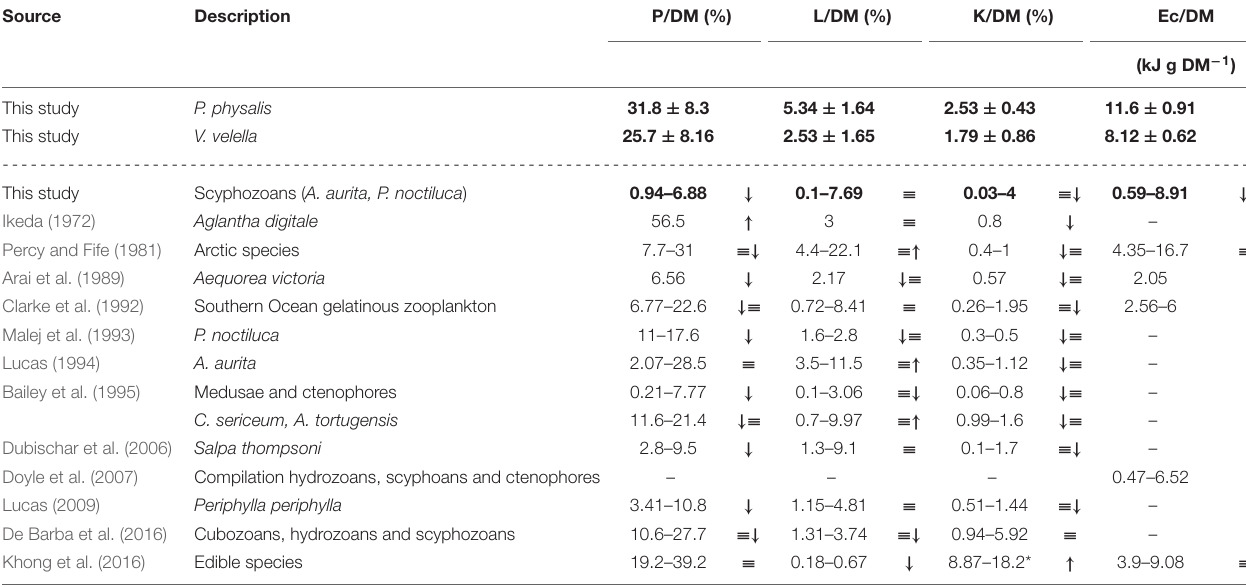
TABLE 5 | Protein (P), Lipid (L), Carbohydrate (K) and energy content (Ec) per dry mass (DM) for P. physalis and V. velella presented as mean ± SD. Source Description